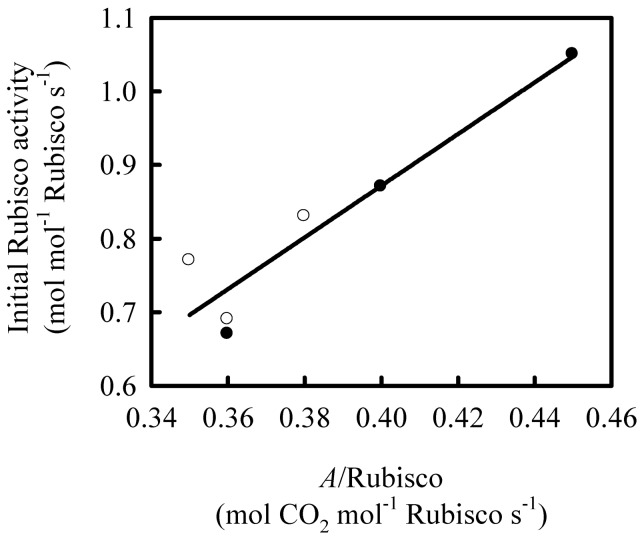
The relationship between initial Rubisco activity and the ratio of leaf photosynthetic rate (A) to Rubisco content on Shanyou 63 (solid cycles) and Yangdao 6 (open cycles).The line represents linear regression: y = 3.51x−0.53 R2 = 0.88 P<0.01.